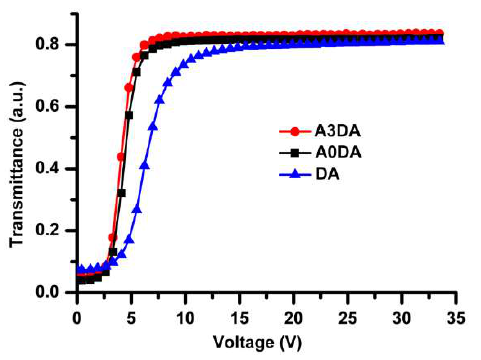
Figure 5. V‐T curves for PDLC films made of different monomers. Figure 5. V-T curves for PDLC films made of di ff erent